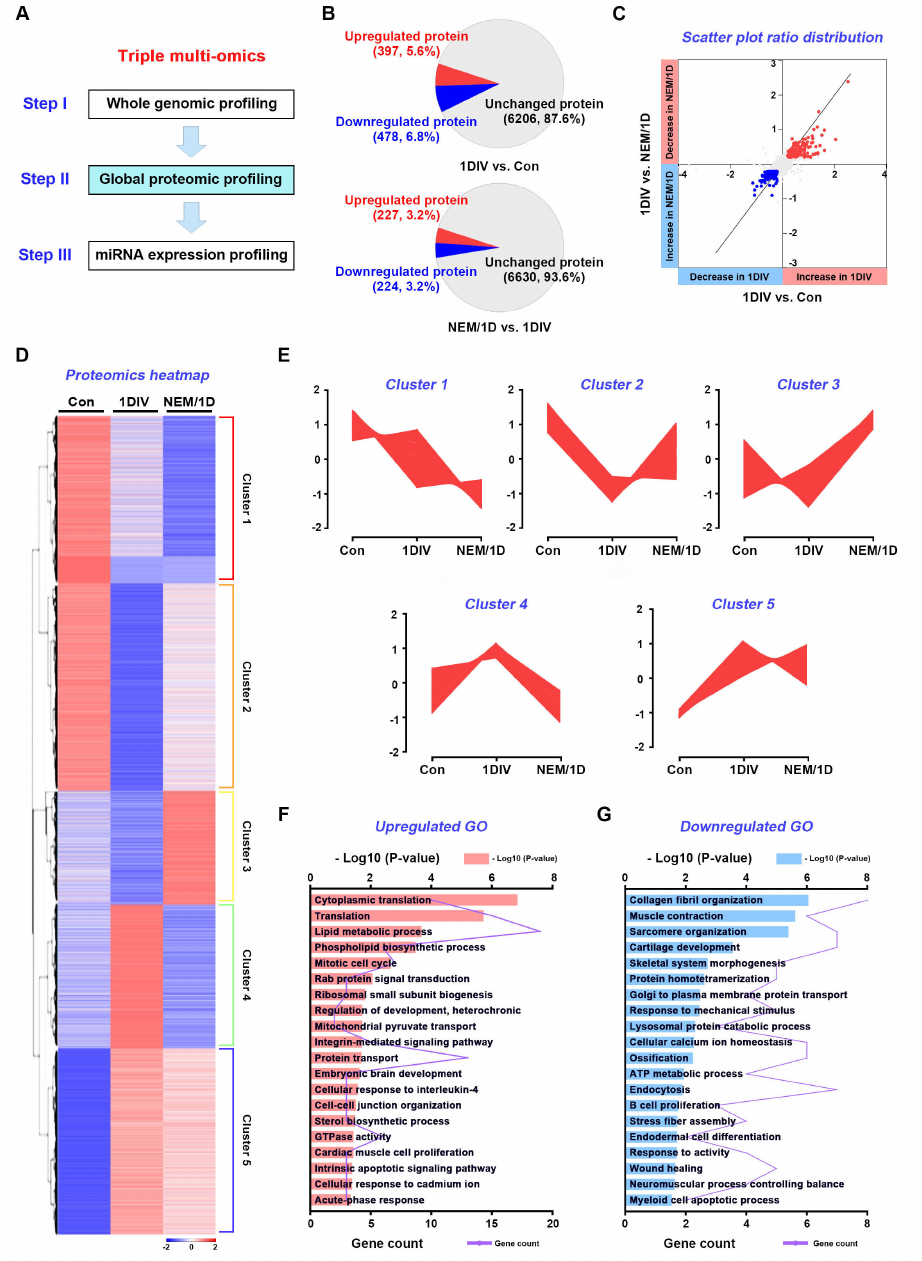
Figure 3. Global proteomics analysis with NEM as an inhibitor for hydrogen sulfide pathway. ( A ) The second stage of a three-stage framework for integrating triple multi-omics data. ( B ) The pie chart displays the numbers of upregulated (log 2 FC > 0.2), downregulated (log 2 FC < − 0.2), and unchanged proteins in the total number of proteins (7149) among control mice nerves (non-injured) and ex vivo mice nerves with or without NEM for 1 day in vitro (1DIV). Control, con; NEM, N -ethylmaleimide; NEM/1D, NEM treatment for 1DIV. ( C ) The fold change (log2) among 7149 proteins in the nerves at 1DIV compared with control (1DIV/Con) is shown on the x -axis. The y -axis shows the change of each protein in the nerves with or without NEM at 1DIV comparison. The red, blue, and gray dots represent decreased proteins at NEM/1D, increased proteins at NEM/1D, and unregulated proteins, respectively. ( D ) Hierarchical clustering (1–5) of ex vivo sciatic nerves at 1DIV (1DIV) vs. control and NEM/1D vs. 1DIV. ( E ) Protein expression dynamic clusters based on global protein expression patterns among control, 1DIV, and NEM/1D. Gene ontology (GO) biological processes upregulated ( F ) and downregulated ( G ) in response to NEM treatment are